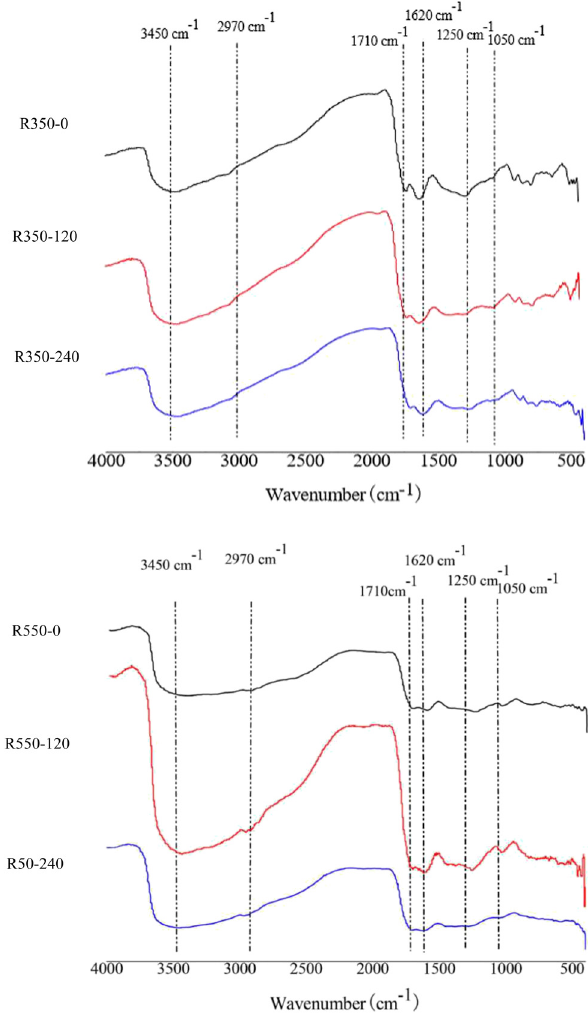
Figure 2: DRIFTS spectra of the biochar samples during the ageing process in soil.